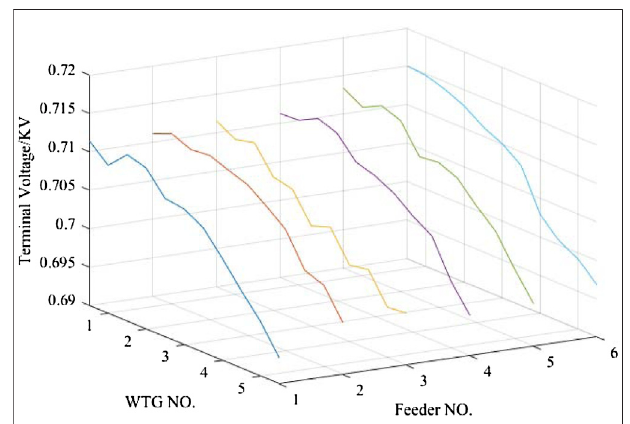
FIGURE 3 | Terminal voltage distribution of